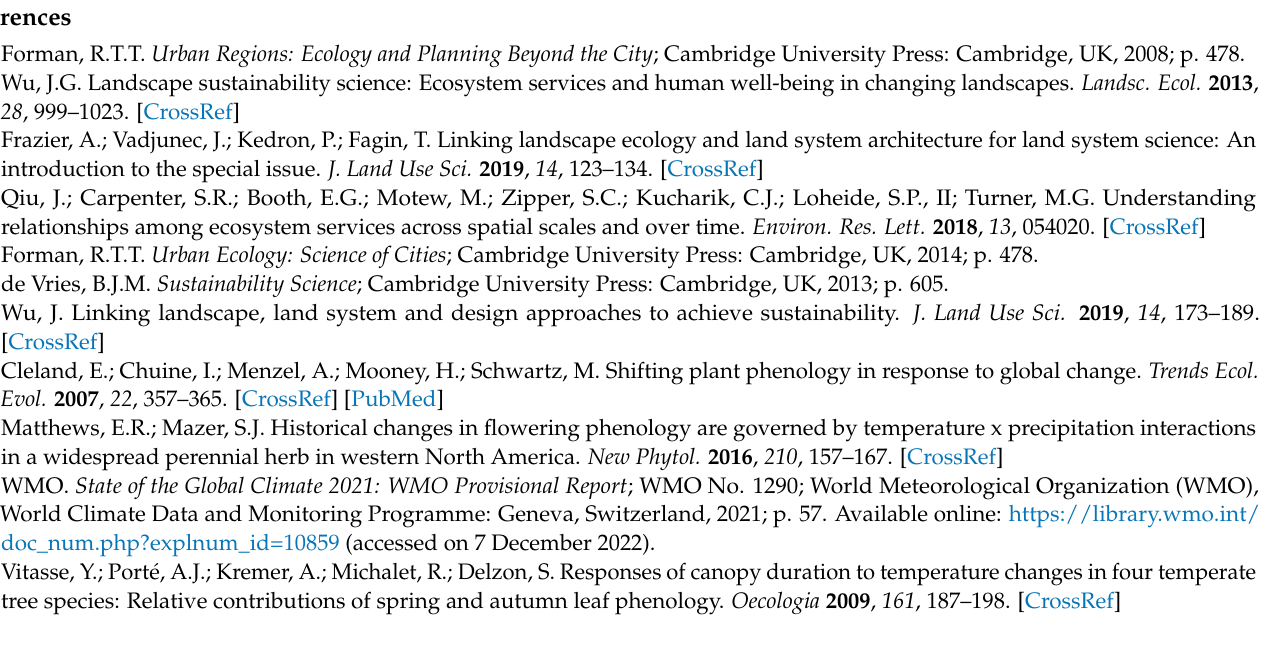
Table S4: Climate variables for 2022, for the reference period 1991-2020 and previous time series: 1981-2010, 1971-2000 and 1961-1990 for stations Belgrade and Surˇcin by season; Table S5: Statistical summary of mean minimum, maximum, and mean temperature sums ( ◦ C), for the beginning of flowering (BF), full flowering (FF), and the end of flowering (EF) and their standard deviations for 13 woody taxa based on data from station Belgrade and Surˇcin for the period 2007-2022; Table S6: Results of Mann-Kendall (Kendall‘s tau), p-value and Sen‘s slope test for the mean values of temperature sums GDD ( ◦ C) and day of the year DOY in the period 2007-2022 for the beginning of flowering (BF), full flowering ( FF), the end of flowering (EF), days from the beginning of the flowering to full flowering (BF-FF) and full flowering to the end of flowering (FF-EF) for 13 woody taxa; Table S7: Statistical summary of average minimum, maximum and mean DOY for the beginning of the flowering (BF), the period from the beginning to full flowering (BF-FF) and full flowering to the end of flowering (FF-EF), and their standard deviations for 13 woody taxa for the period